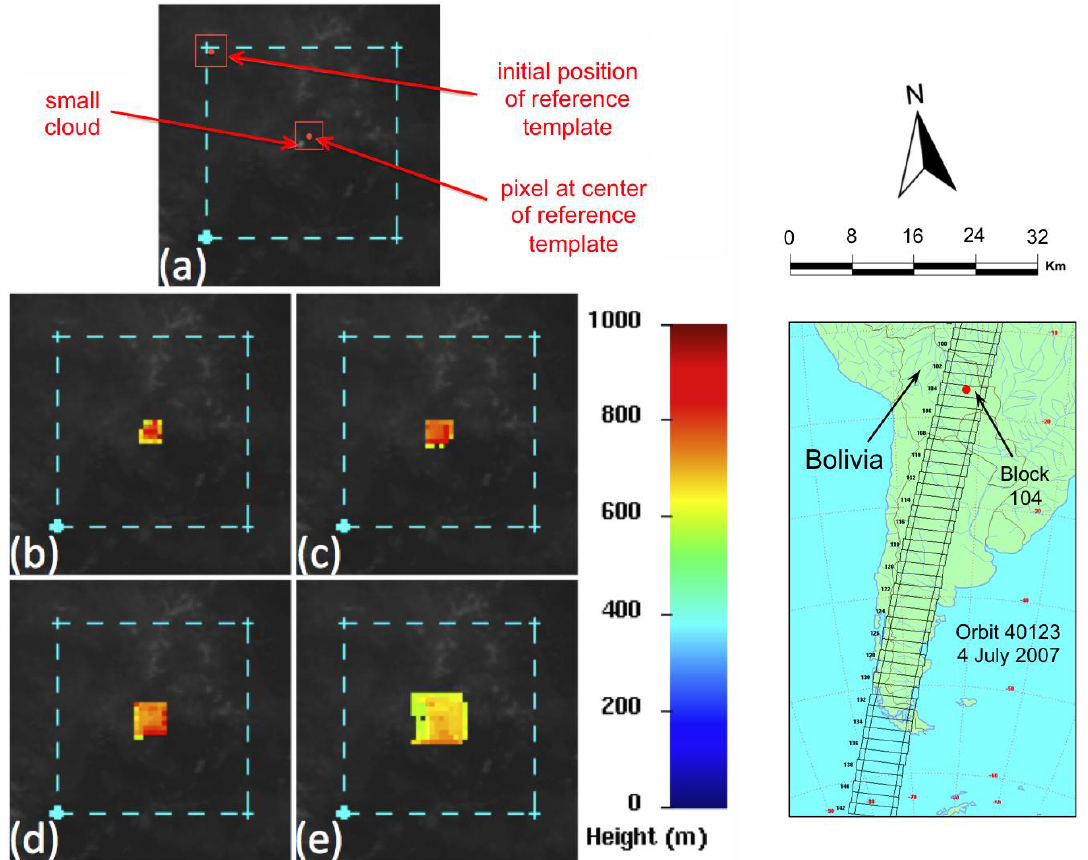
Figure 3. Zero-wind height retrievals over a single 1 km diameter cloud on orbit 40123, block 104, using different image matcher template sizes to demonstrate their smearing effect. The dashed aqua lines represent the digitized polygon inside which height retrievals are attempted. ( a ) Image with small cloud at center; ( b ) heights using 7 × 7 pixel template; ( c ) heights using 9 × 9 template; ( d ) heights using 13 × 13 template; and ( e ) heights using 23 × 23